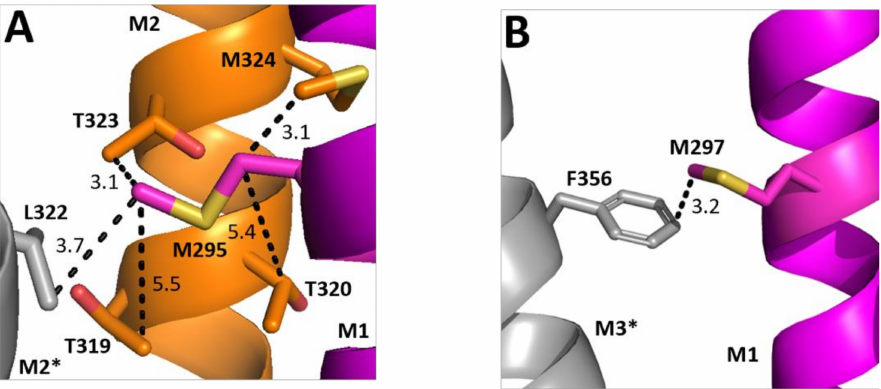
Figure 7. Possible M1 helix Met interactions. Residues close to M295 ( A ) and M297 ( B ) showing the M1 helix (magenta), the M2 helix (orange), and the neighbouring M3 helix (grey). Distances are in Å. * indicates a neighbouring